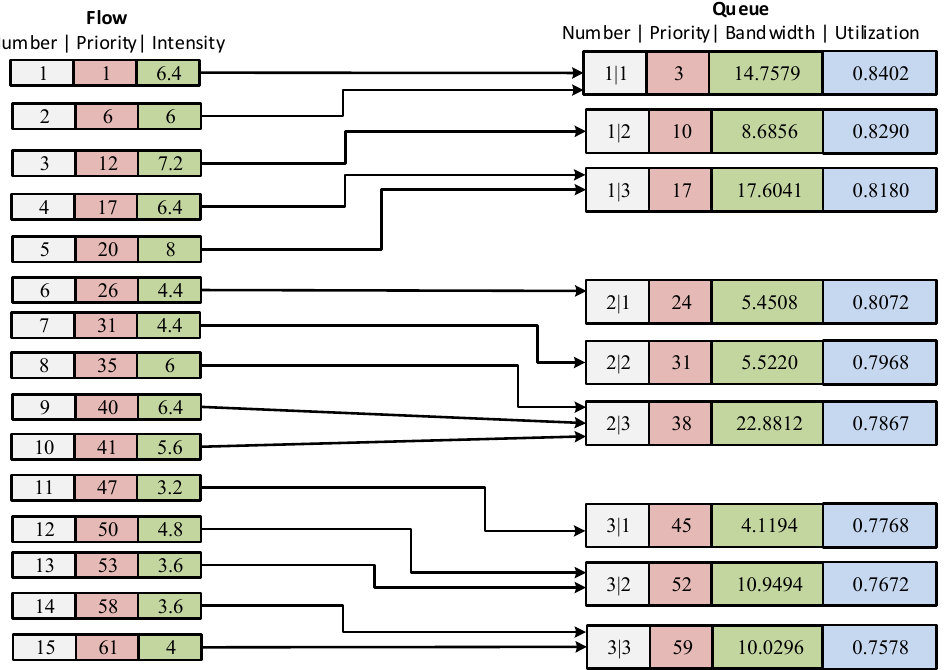
Figure 2. The resulting solution for interface bandwidth allocation among the sub-queues of three macro-queues. Table 7. The interface bandwidth allocation among the sub-queues of three macro-queues and their utilization.